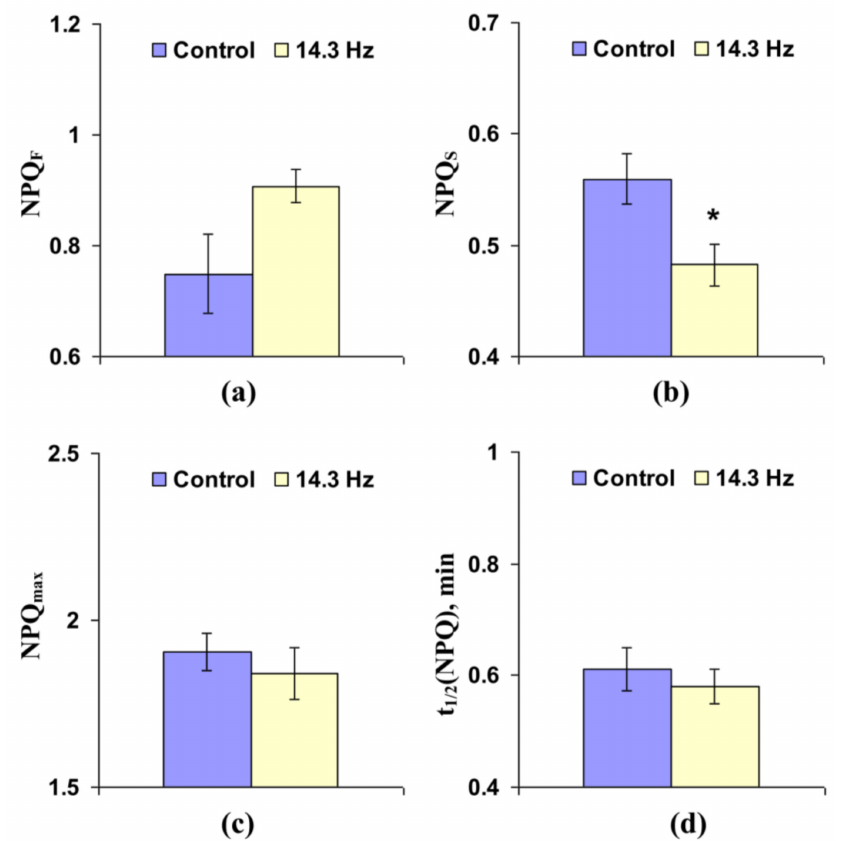
Figure 10. Influence of chronic treatment by the artificial extremely low frequency magnetic field on fast-relaxing component of non-photochemical quenching under illumination (NPQ F ) ( a ), slow- relaxing component of non-photochemical quenching after this illumination (NPQ S ) ( b ), maximal value of non-photochemical quenching (NPQ max ) ( c ), and time taken for 50% increase of NPQ under illumination (t 1/2 (NPQ)) ( d ) in pea seedlings ( n = 6). Chronic action of the artificial magnetic field was initiated from soaking of seeds. Magnitude of the magnetic field was 18 µ T; frequency was 14.3 Hz. Photosynthetic parameters were measured by the action of this field. Control plants were not treated by this artificial magnetic field. *, difference between the experiment and control plants was significant ( p <